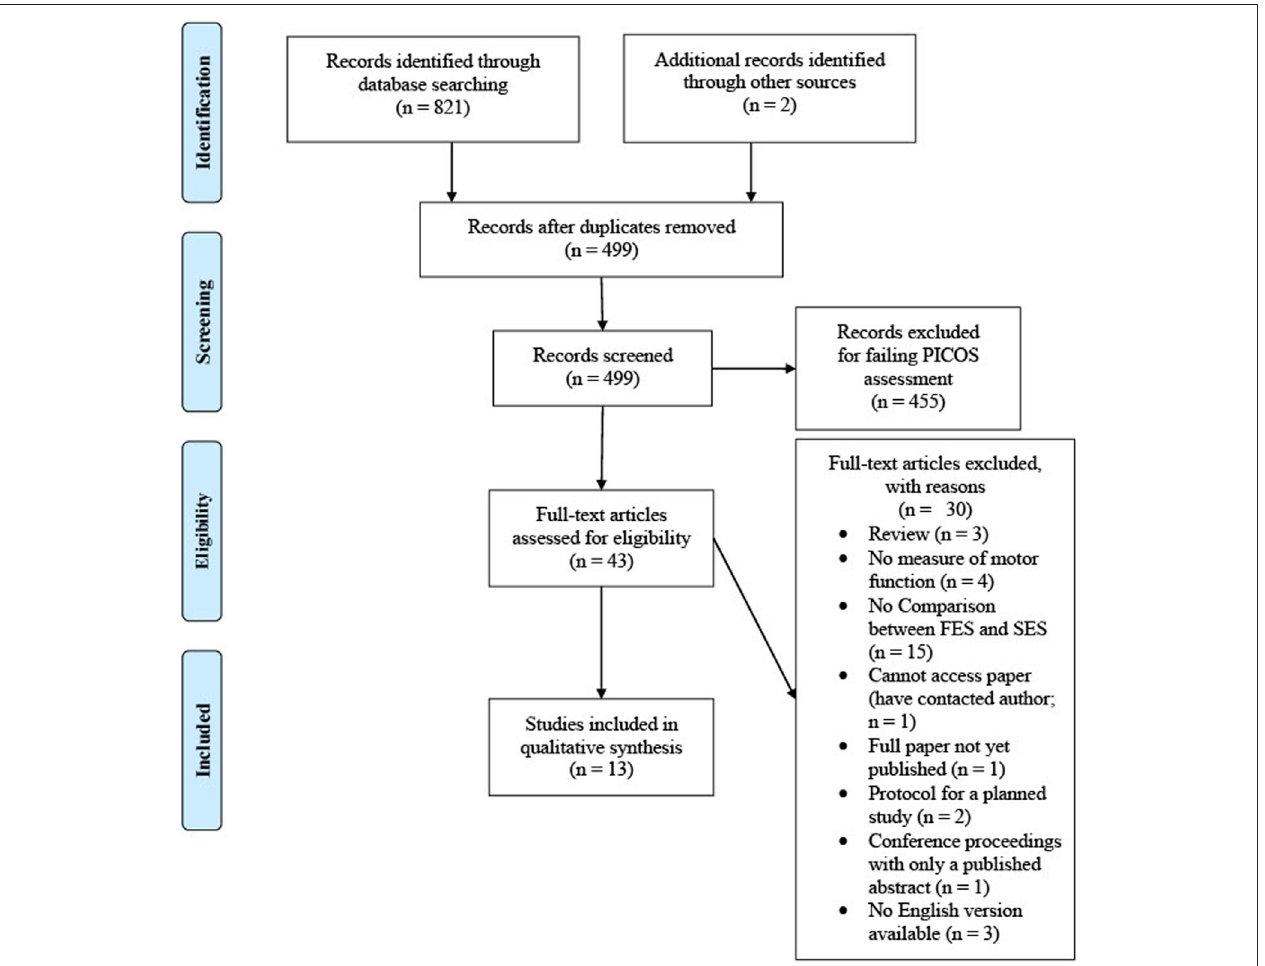
FIGURE 1 | Prisma fl ow